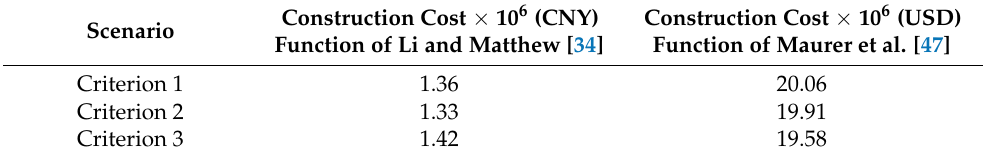
Table 3. Construction cost for each criterion in the benchmark proposed by Li and Matthew [34].